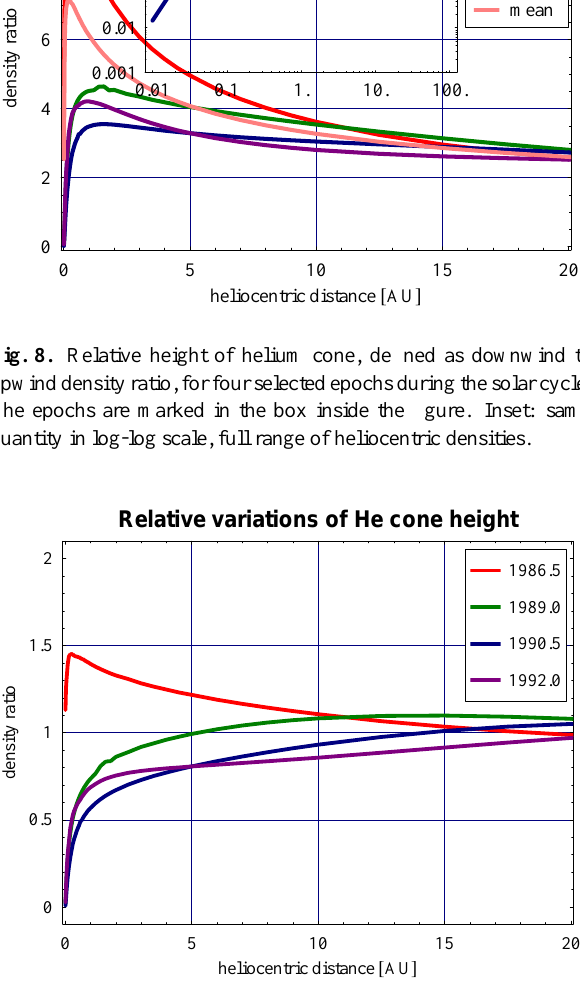
Fig. 9. Variations of the relative helium cone height during the solar cycle with respect to the mean helium cone height as a function of the heliocentric distance for selected